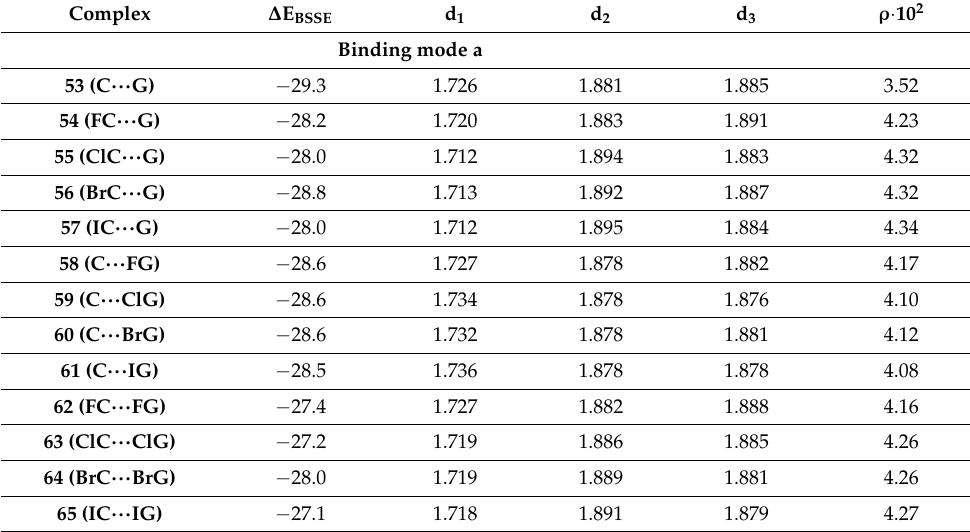
Figure 4. Schematic representation of the binding modes studied for the U ··· A halogenated BP. Intermolecular distances (d 1 and d 2 ) are gathered in Table 3. Table 4. BSSE corrected interaction energies ( ∆ E BSSE , in kcal/mol), equilibrium distances (d 1 , d 2 and d 3 in Å), and value of the density at the bond critical point corresponding to the strongest interaction ( ρ · 10 2 in a.u.) for the C ··· G complexes 53 to 104